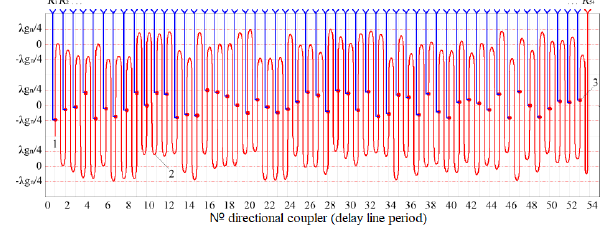
FIGURE 13. Offsets of the bends of the delay line (1) and directional coupler (2) relative to the center line of the power divider.